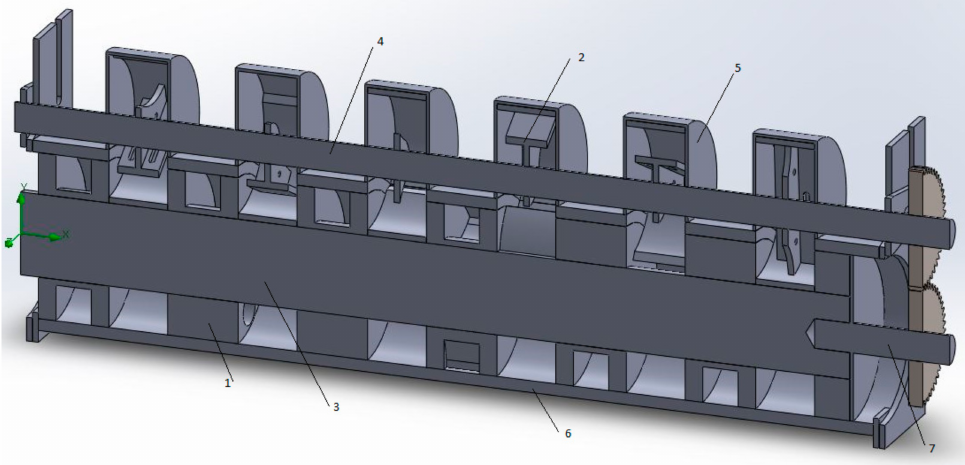
Figure 18. General view of the volume-sectional hydraulic engine.